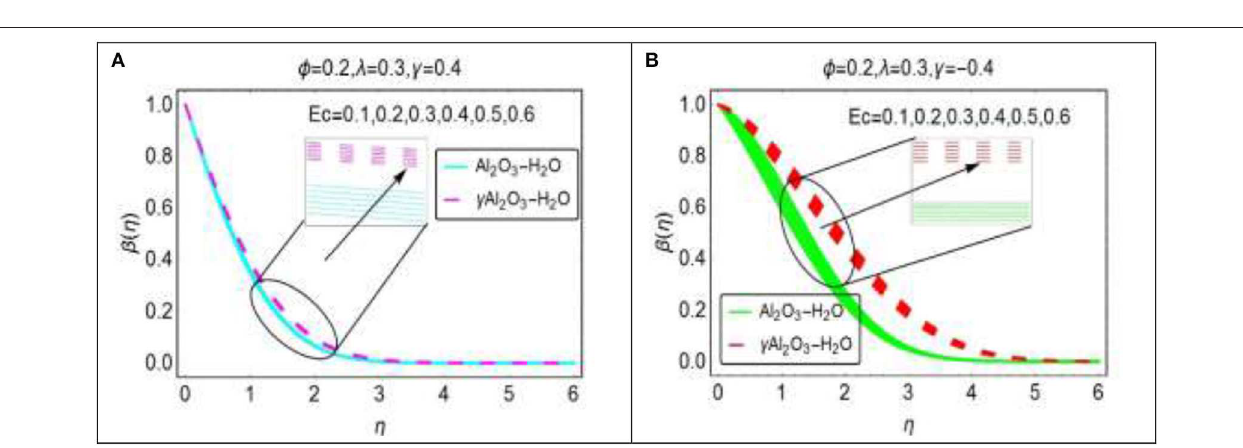
FIGURE 9 | The effects of Ec on dimensionless temperature β ( η ) for (A) γ = 0.4, (B) γ = − 0.4.